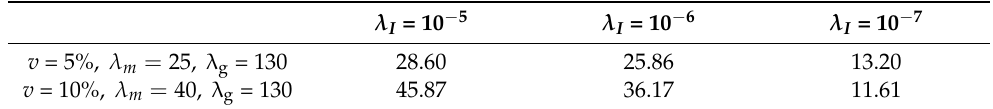
Table 1. The calculated values of nodular cast iron corresponding to different assignments of thermal conductivity of the virtual grids. Unit: W/(m · K).